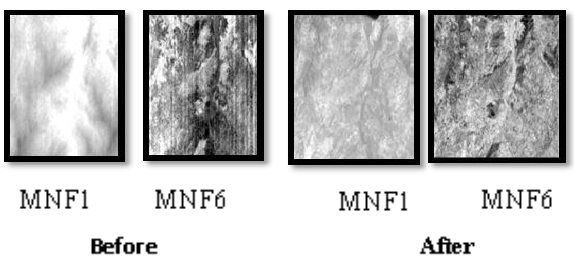
Figure 2. Testing the Effects of destriping using the